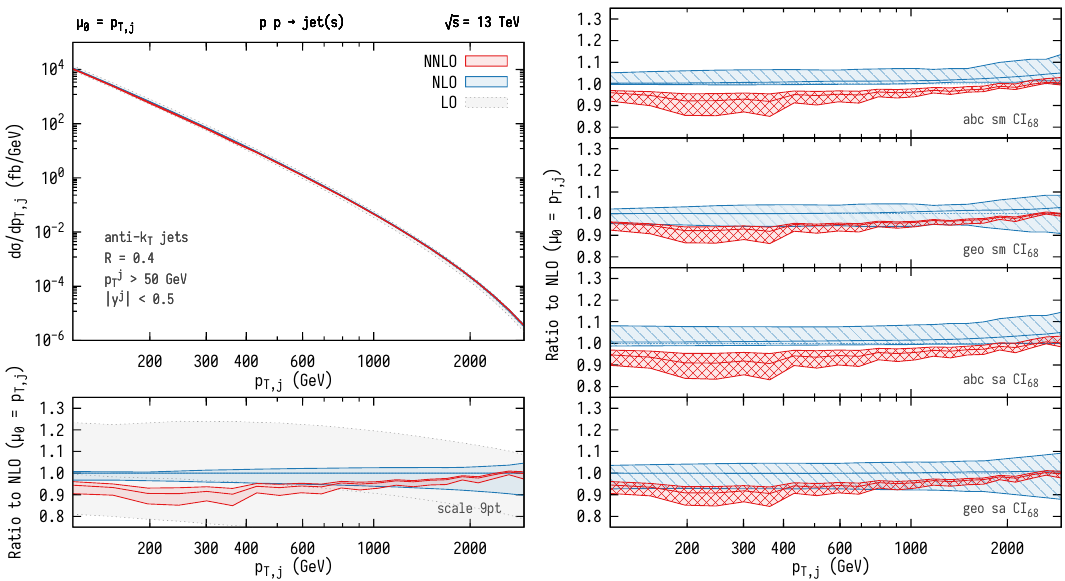
Figure 22 . Inclusive jet production up to NNLO with µ 0 = p T,j as the central scale choice. Left: absolute dσ/dp distributions and 9-point scale variation envelopes normalised to the NLO predic- T,j tion at µ . Right: 68% CIs for the abc and geometric models using the scale-marginalisation (top) 0 and scale-averaging (bottom) prescriptions (also normalised to NLO).